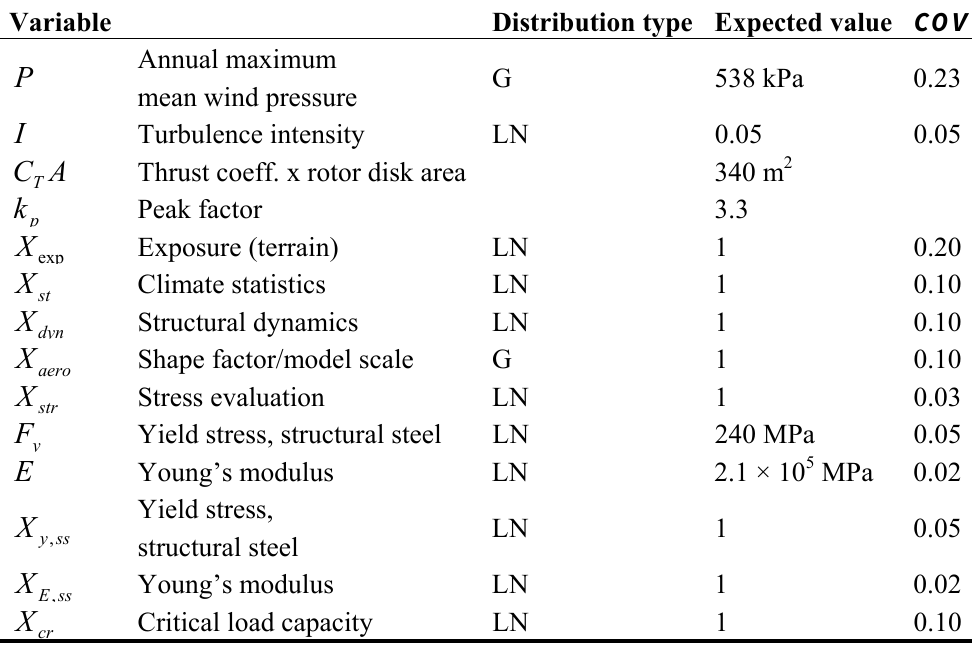
Table 1. Stochastic variables for local buckling failure mode. Variables denoted X model model-uncertainties. LN: Lognormal, G: Gumbel. COV : coefficient of